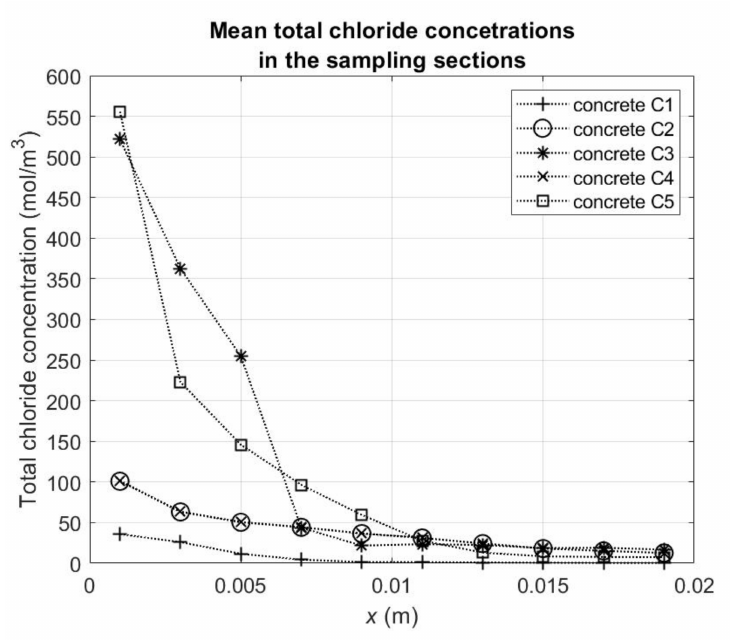
Figure 2. Average concentrations of total chlorides C t exp in the successive 2 mm thick sampling sections of concrete C1–C5 samples (based on the values from Table 4). Coordinate x = 0 relates to the specimen external surface exposed to the chloride